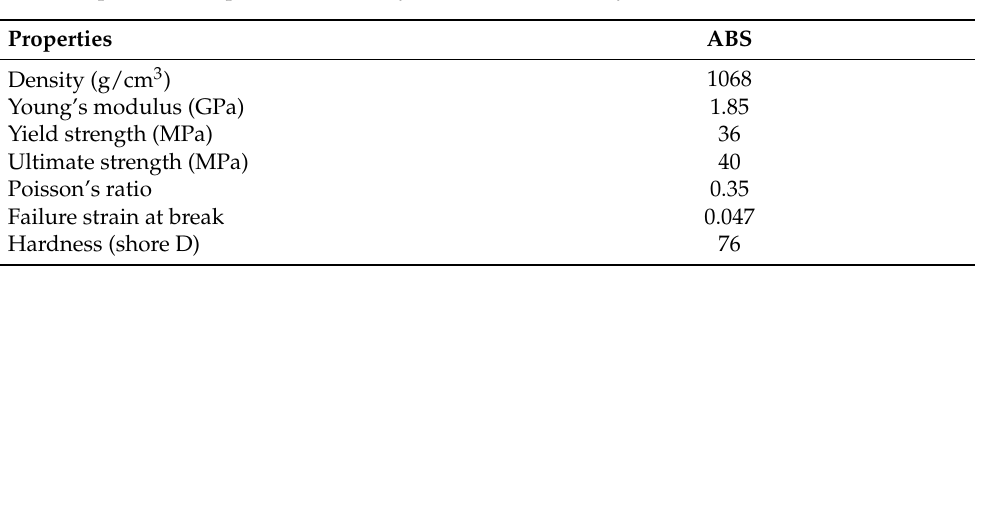
Table 4. Input material parameters of acrylonitrile butadiene styrene